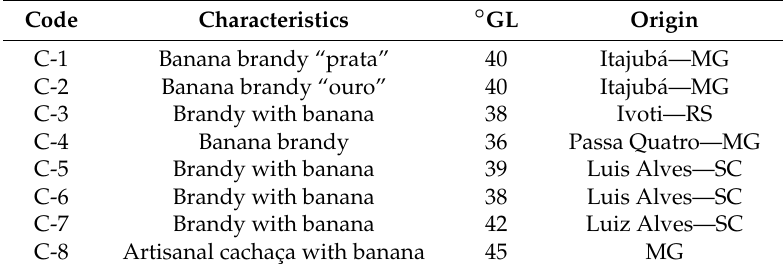
Table 1. Characteristics and commercially produced banana alcoholic beverages from Minas Gerais (MG), Rio Grande do Sul (RS) and Santa Catarina (SC). Code Characteristics ◦